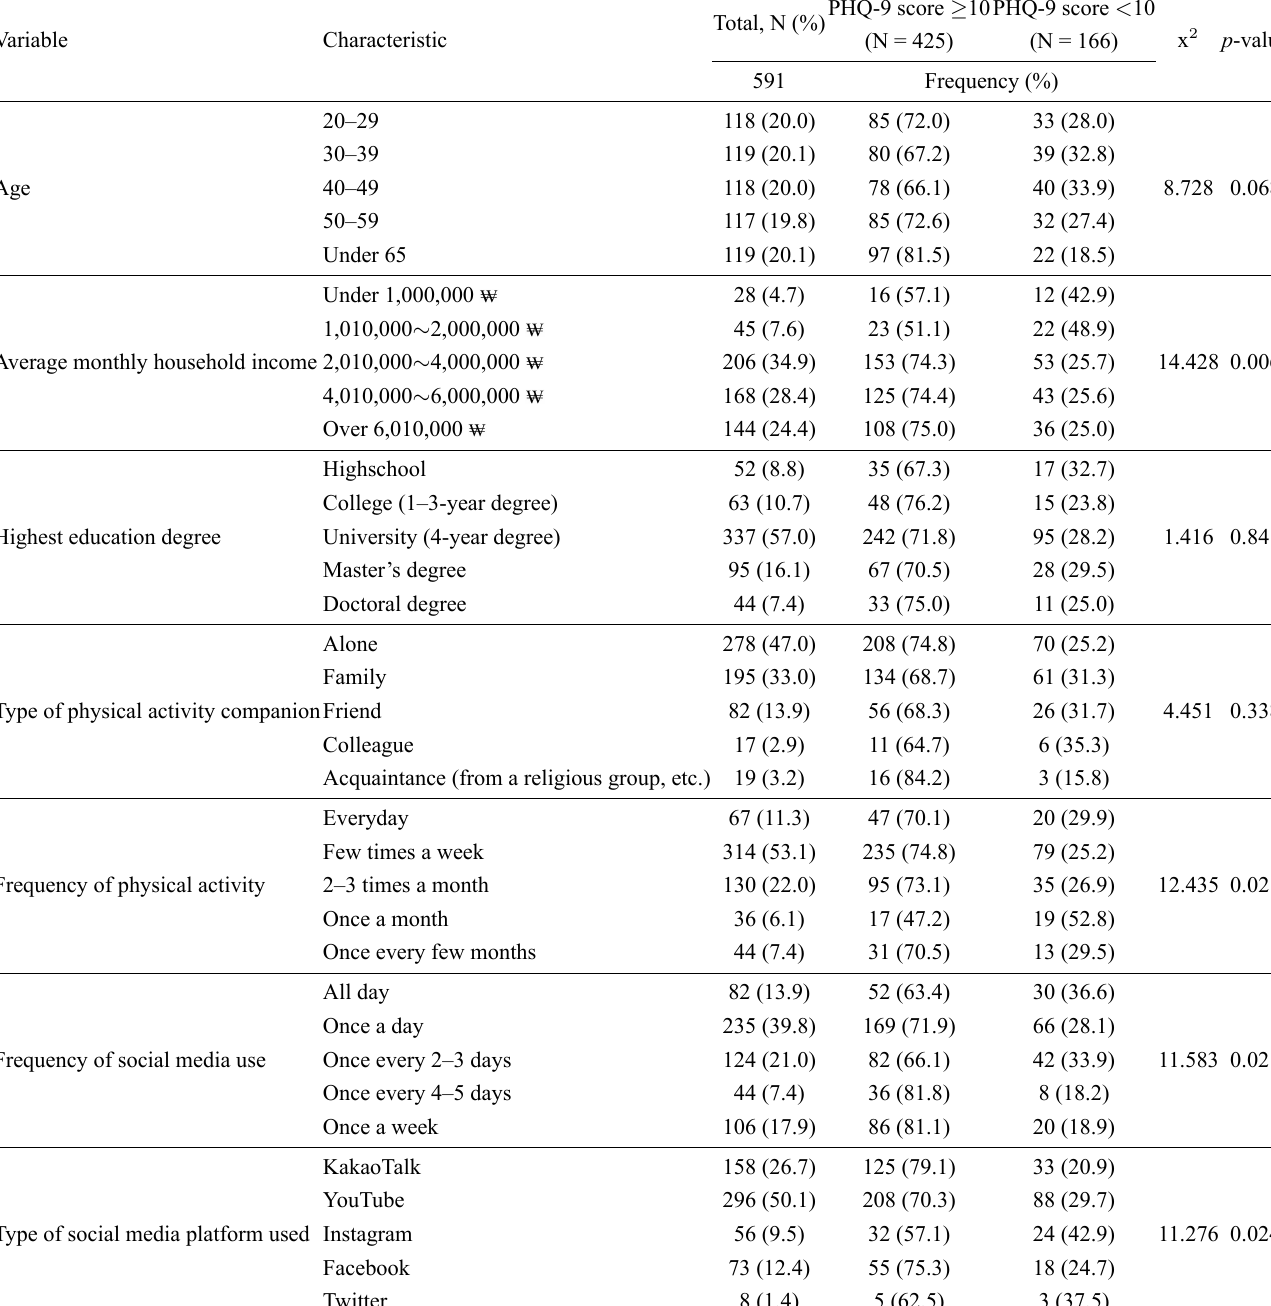
Table 1. Participants’ demographic and personal characteristics (N =